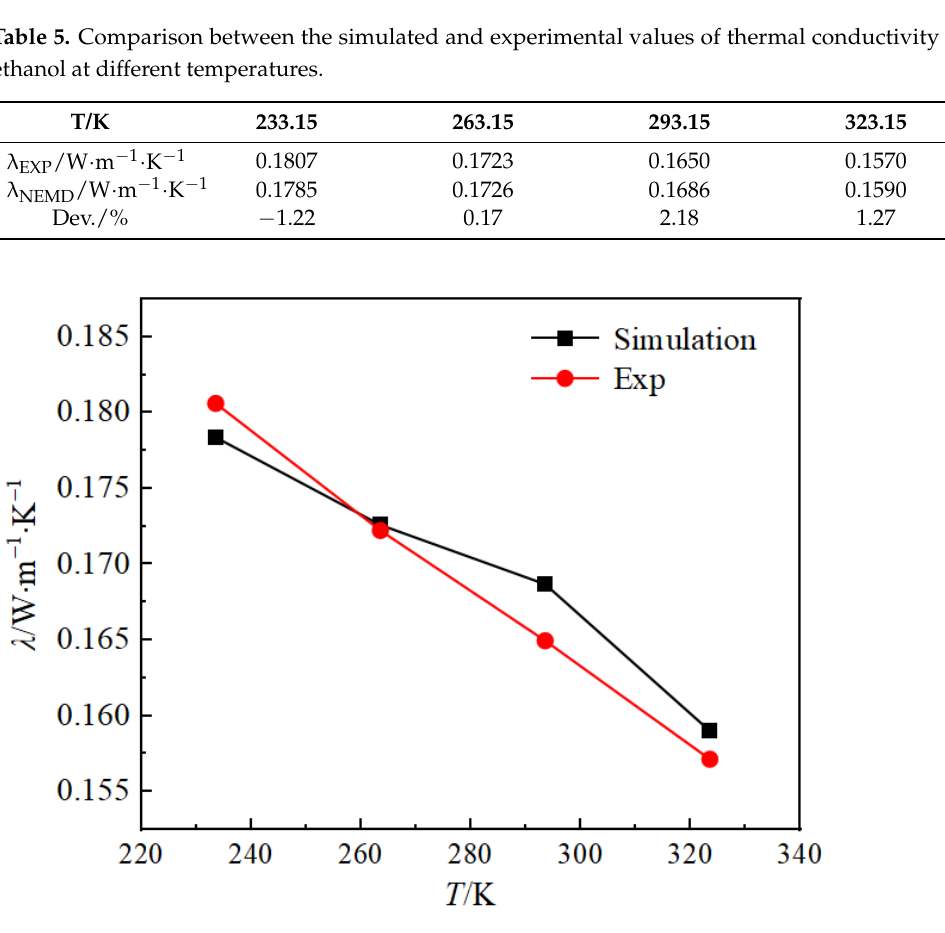
Figure 2. Comparison between the simulated and experimental values of thermal conductivity for ethanol at different temperatures.